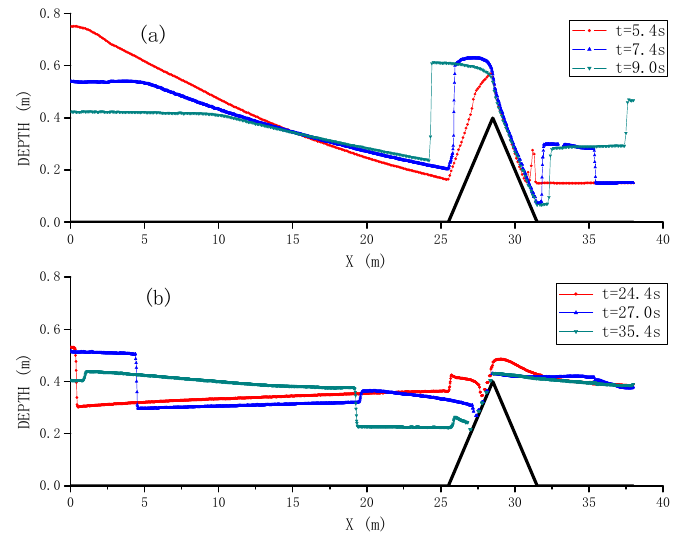
Figure 3. Spatial and temporal evolutions of the dam break flow surface profile at time: ( a ) t = 5.4, 7.4 and 9.0 s; and ( b ) t = 24.4, 27.0 and 35.4 s.